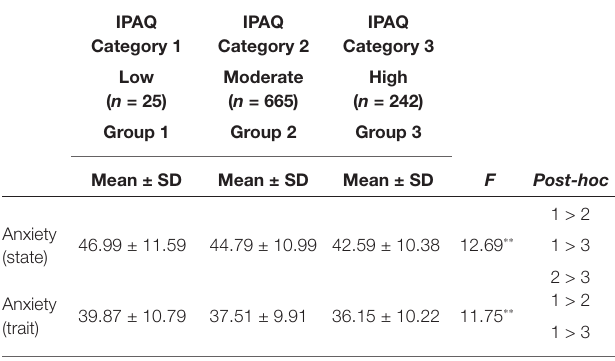
TABLE 3 | Comparison between the IPAQ categories, anxiety levels ( n = 1,332). IPAQ Category